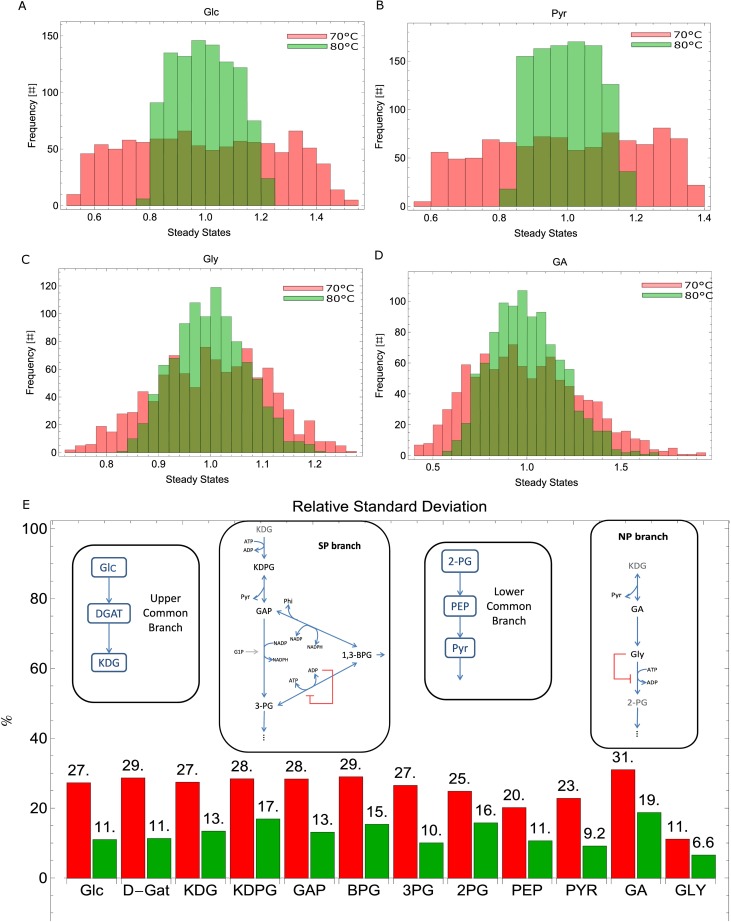
Stochastic internal perturbations.Histograms accounting for metabolites’ relative steady state variations after stochastically varying Vmax. Red: 70°C, Green: 80°C. A) Glc; B) Pyr; C) Gly; D) GA; E) RSD and network elements. # means counts.